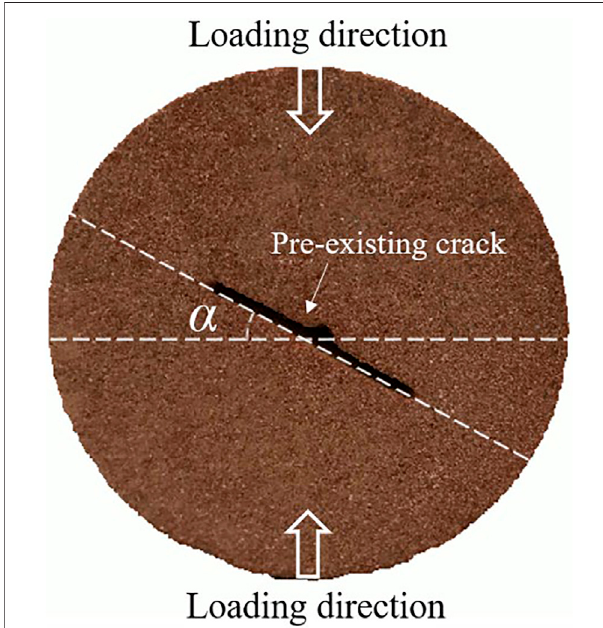
FIGURE 1 | Schematic diagram of the Brazilian test on the sandstone disk specimen containing pre-existing cracks.